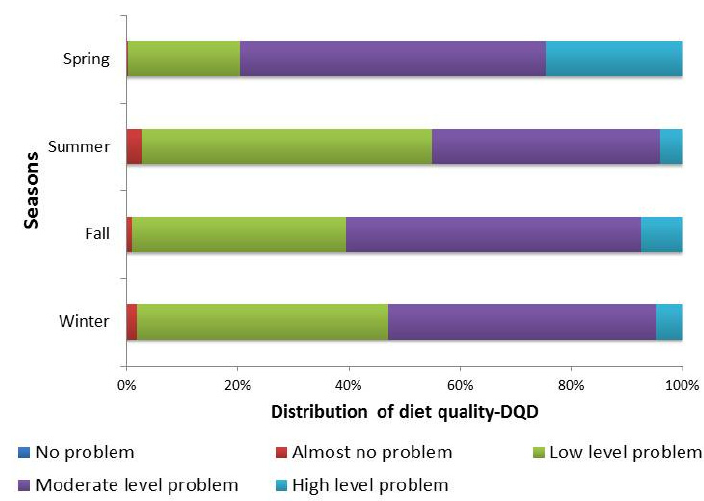
Figure 3. Distribution of the diet quality distance (DQD) (Score range of DQD is 0–84; No problem: 0; Almost no problem: 1–17; Low level: 18–34; Moderate level: 35–50; High level: >50.